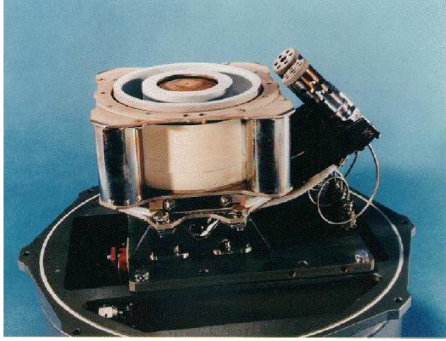
Figure 5. Picture of SPT-100 [39].